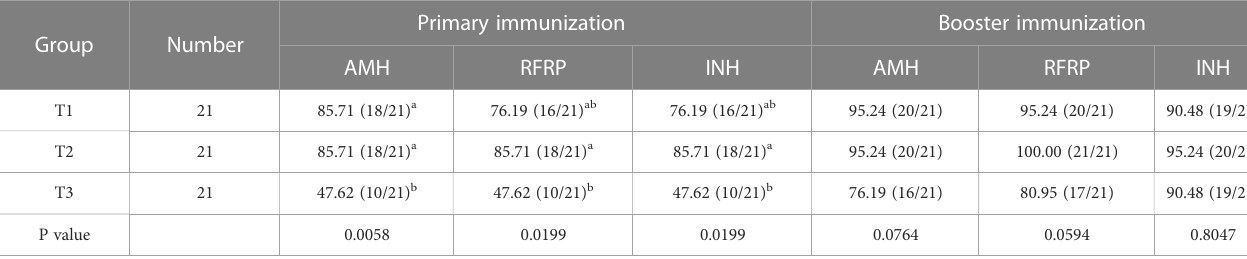
TABLE 1 Percentage (and proportion) of buffalo with positive antibody against AMH, RFRP and INH at various intervals after immunization of DNA vaccine.